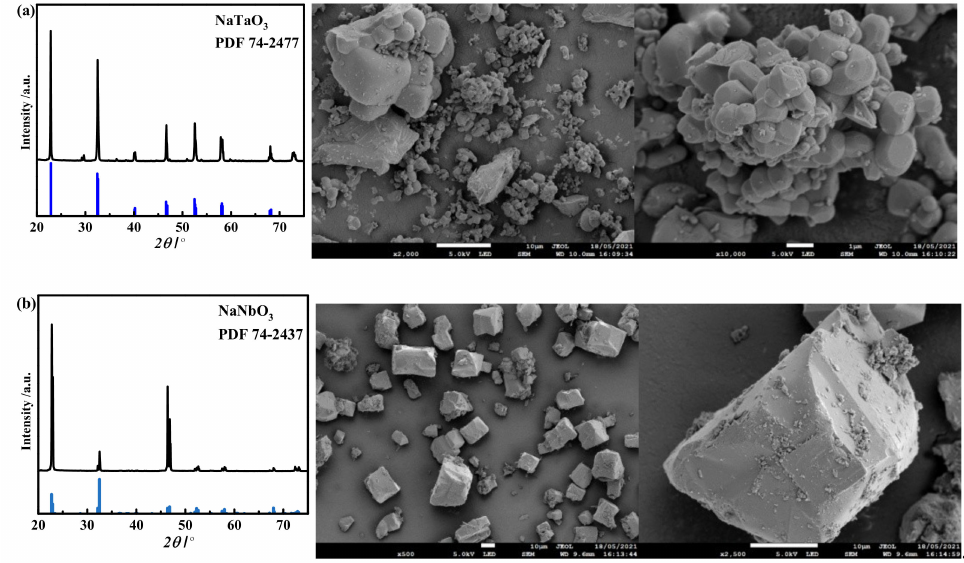
Figure 10. XRD and SEM images of synthesized sodium tantalate ( a ) and sodium niobate ( b